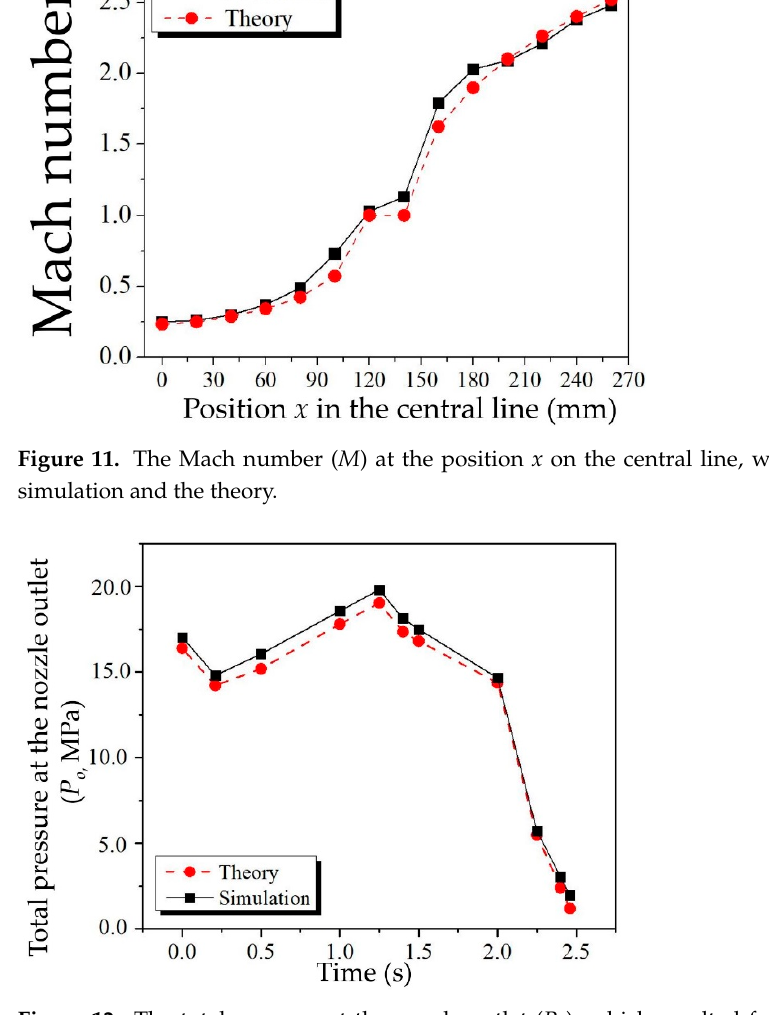
Figure 12. The total pressure at the nozzle outlet ( P o ), which resulted from the simulation and the